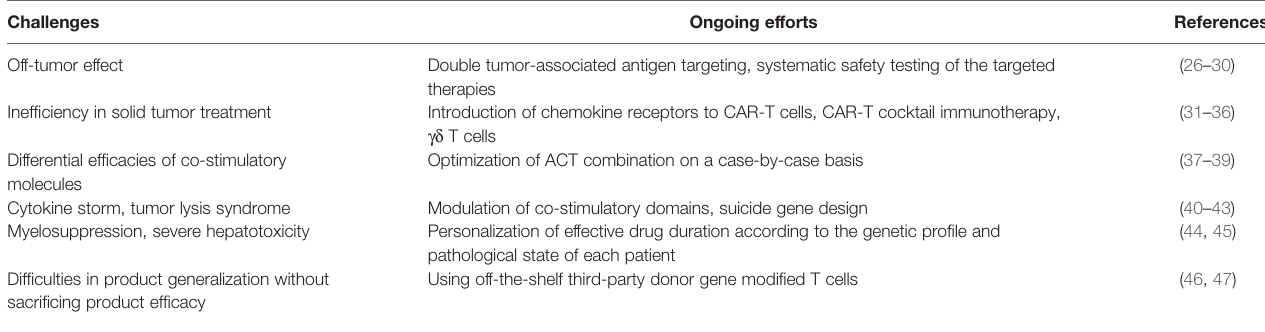
TABLE 1 | Challenges faced by the CAR-T therapies and the ongoing